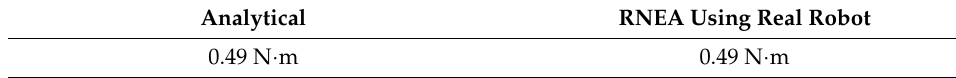
Table 1. Torque generated at 4th